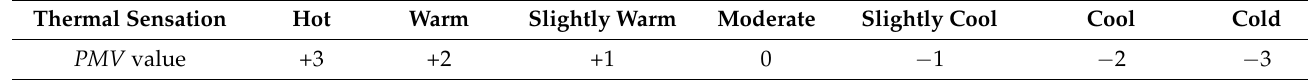
Table 1. PMV level and human thermal